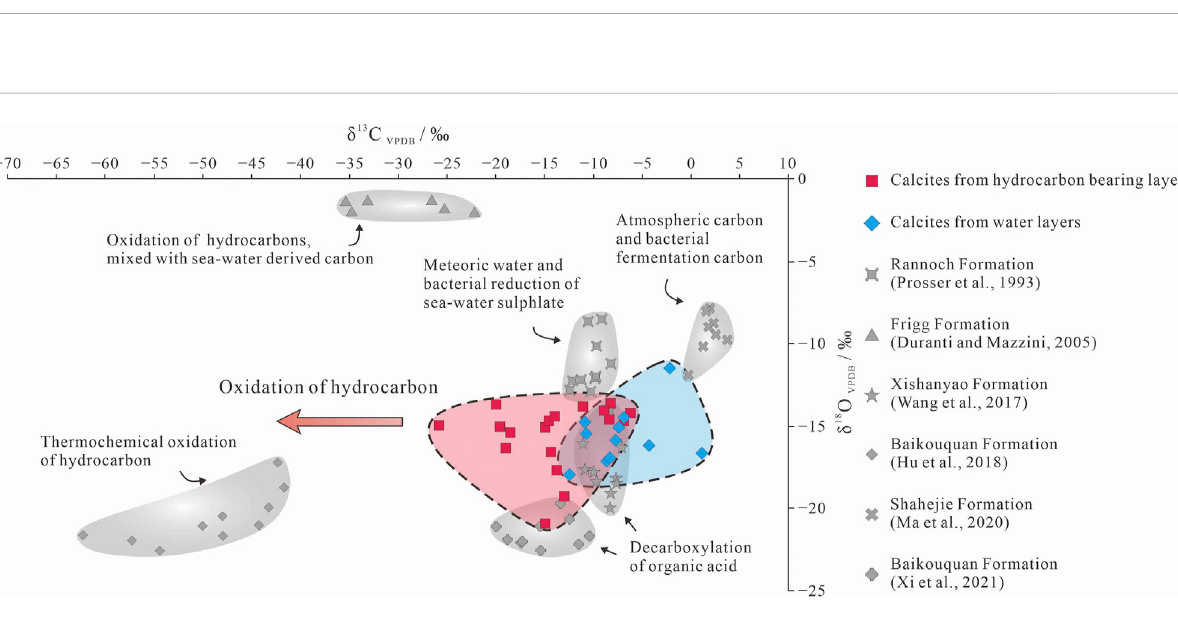
Frontiers in Earth